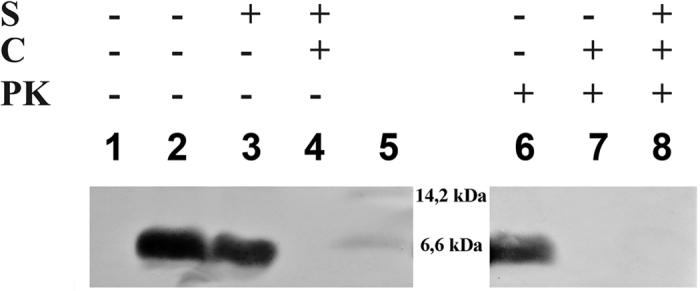
Thylakoid membrane fractions after insertion of PsbW.The integration of the PsbW into the thylakoid membrane the presence or absence of stromal fraction was analysed by Western blot. Lane 1, thylakoid membrane before insertion; lanes 2–4 and 6–8, thylakoid membrane after insertion of PsbW; and lane 5, molecular weight standard. Antibodies against biotin were used for immunodetection. C - membrane treated with carboxypeptidase B after protein insertion, PK - membrane treated before protein insertion with proteinase K. On each lane, 10 μg of protein was applied. Identification of psbW protein in Western blot was also confirmed using MS.